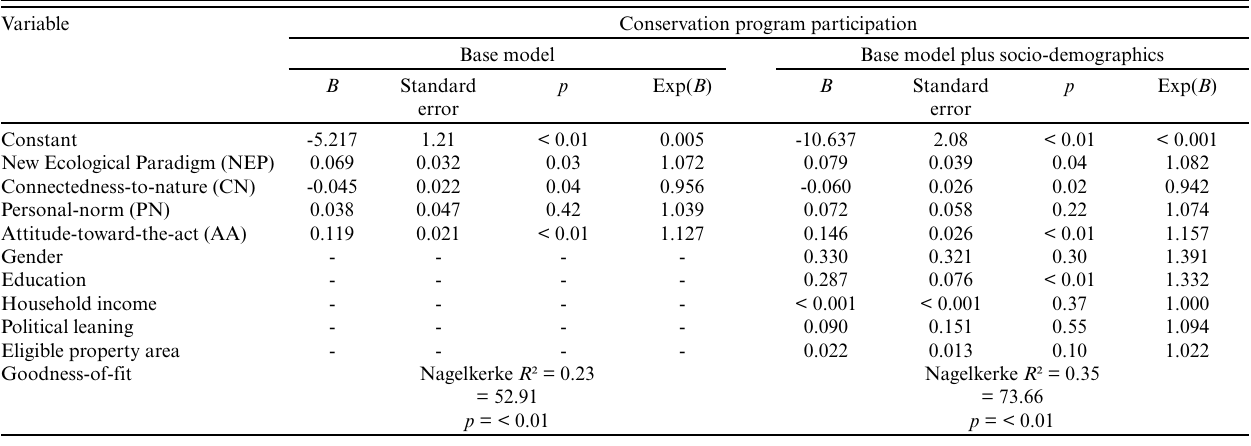
Table 5 . Combined model of conservation program